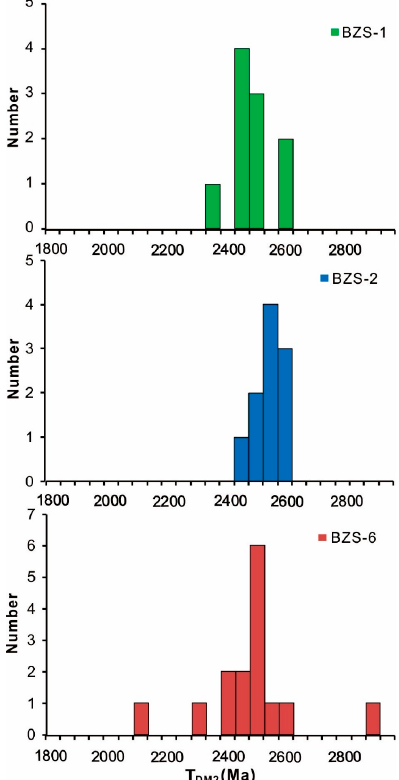
Figure 7. Histograms of the T DM2 ages for the zircons from the Banzhusi granite porphyry.